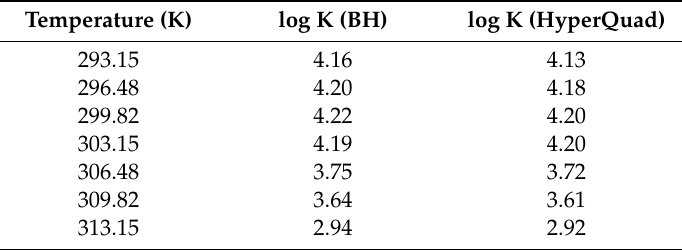
Table 2. Thermodynamic parameters of the complex formation between TAC and MTX